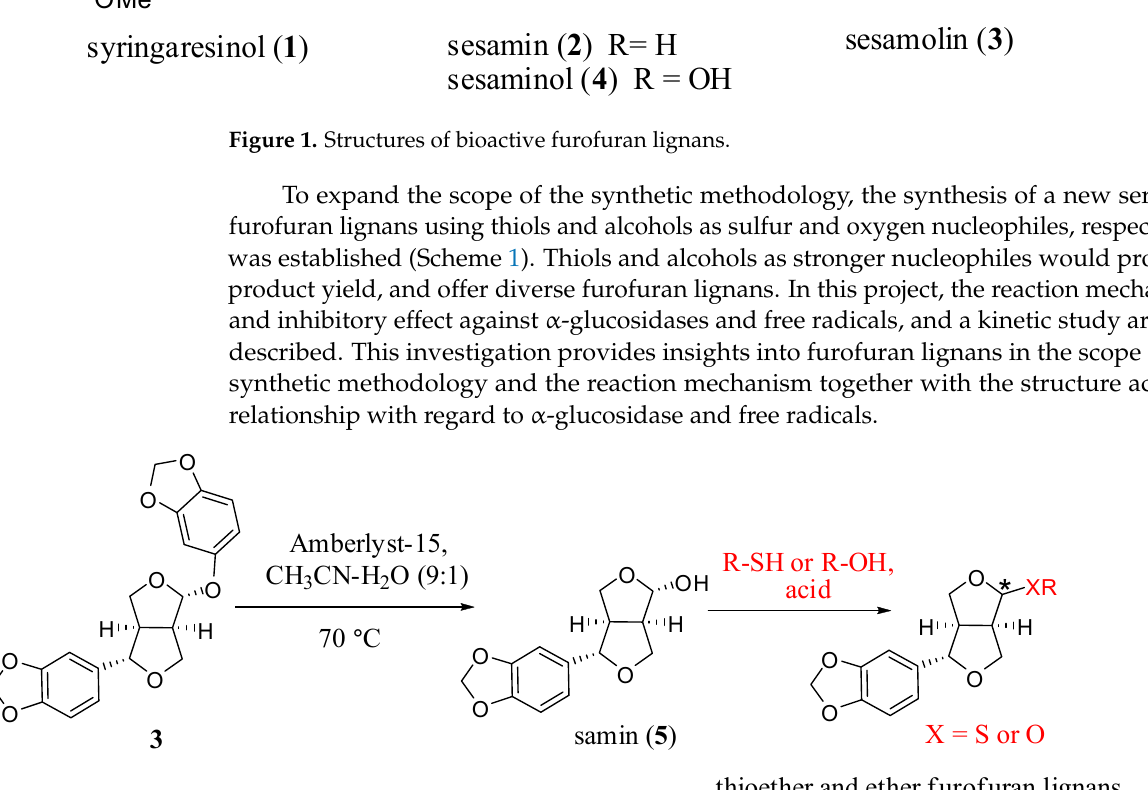
Scheme 1. Synthetic strategy for thioether and ether furofuran lignans.